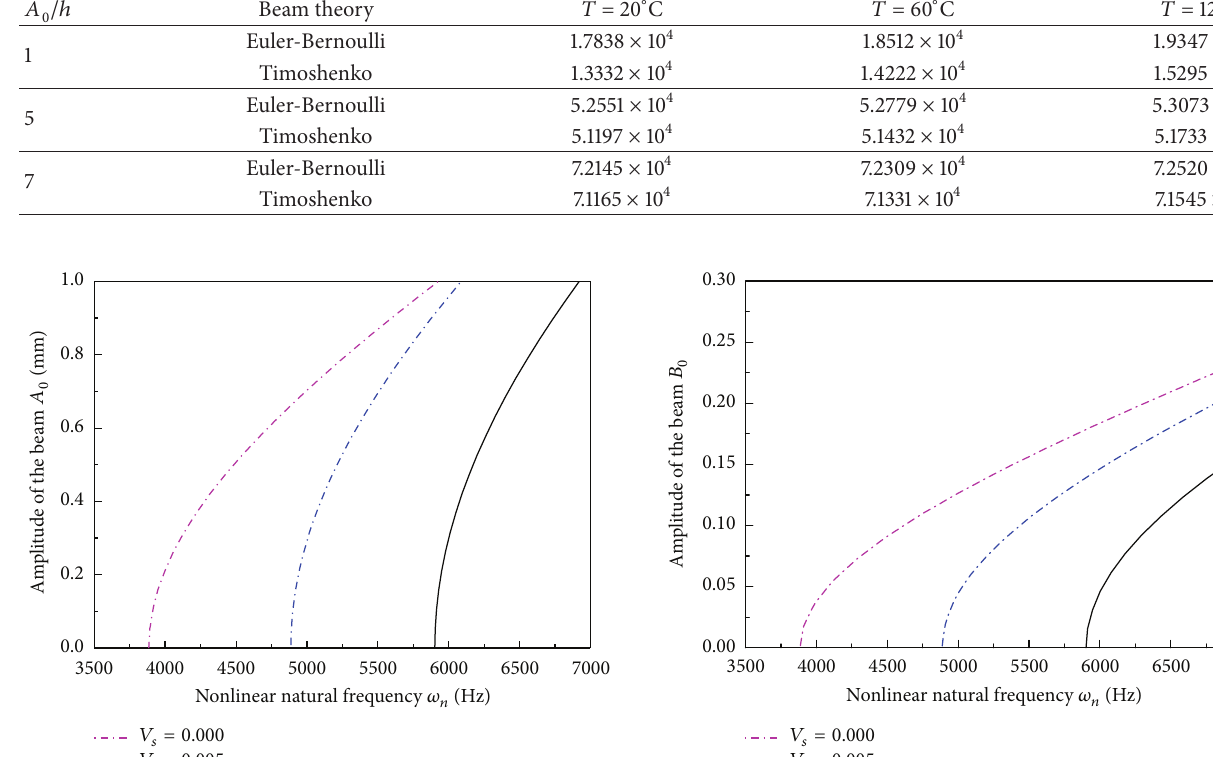
Table 6: The nonlinear natural frequency for different values of 𝑇 with various 𝐴 0 /ℎ ( 𝐿/ℎ = 6 , 𝜀 0 = 0.03 , and 𝑉 𝑠 = 0.005). 𝐴 /ℎ 0